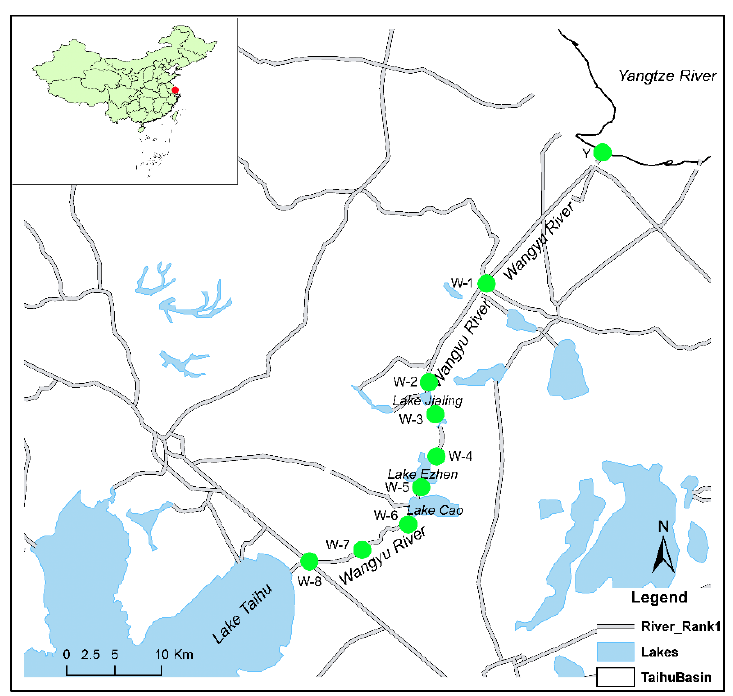
Figure 1. Location of the study area and sampling sites.